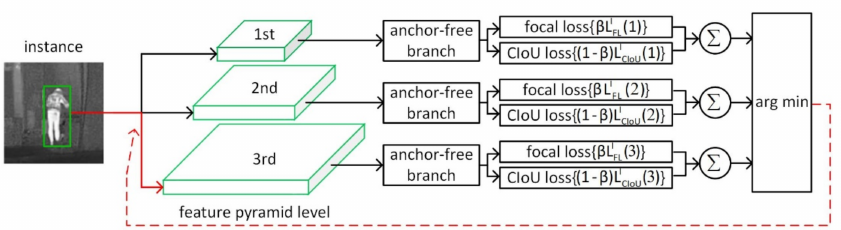
Figure 2. Online feature selection mechanism of the anchor-free branches of the FSAF module with the weight parameter β . Each instance is passing through all levels of anchor-free branches to compute the classification (focal) loss and regression (Complete Intersection over Union (CIoU)) loss. Then, the level with the minimal summation of two losses is selected to set up the supervision signals for learning the